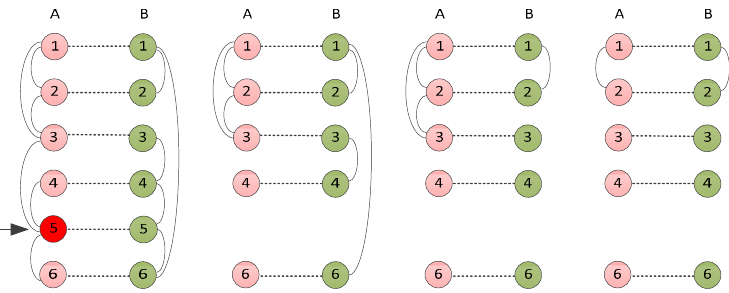
Figure 4. The specific process of cascading failure in a cyber physical power system.